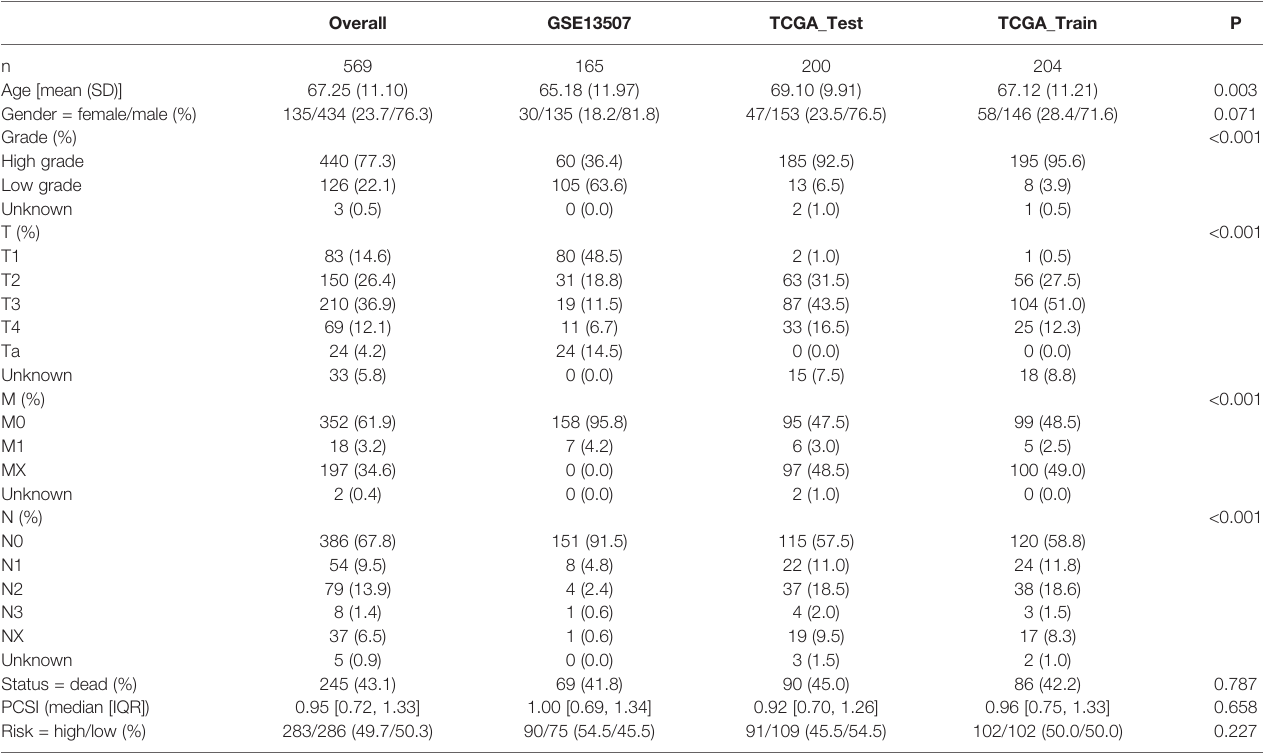
TABLE 1 | The basic characteristics of included patients.